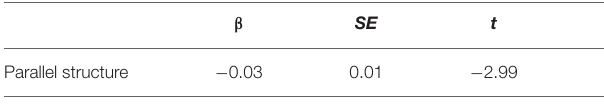
TABLE 2 | Model of the L1 data (Experiment 1). β SE p